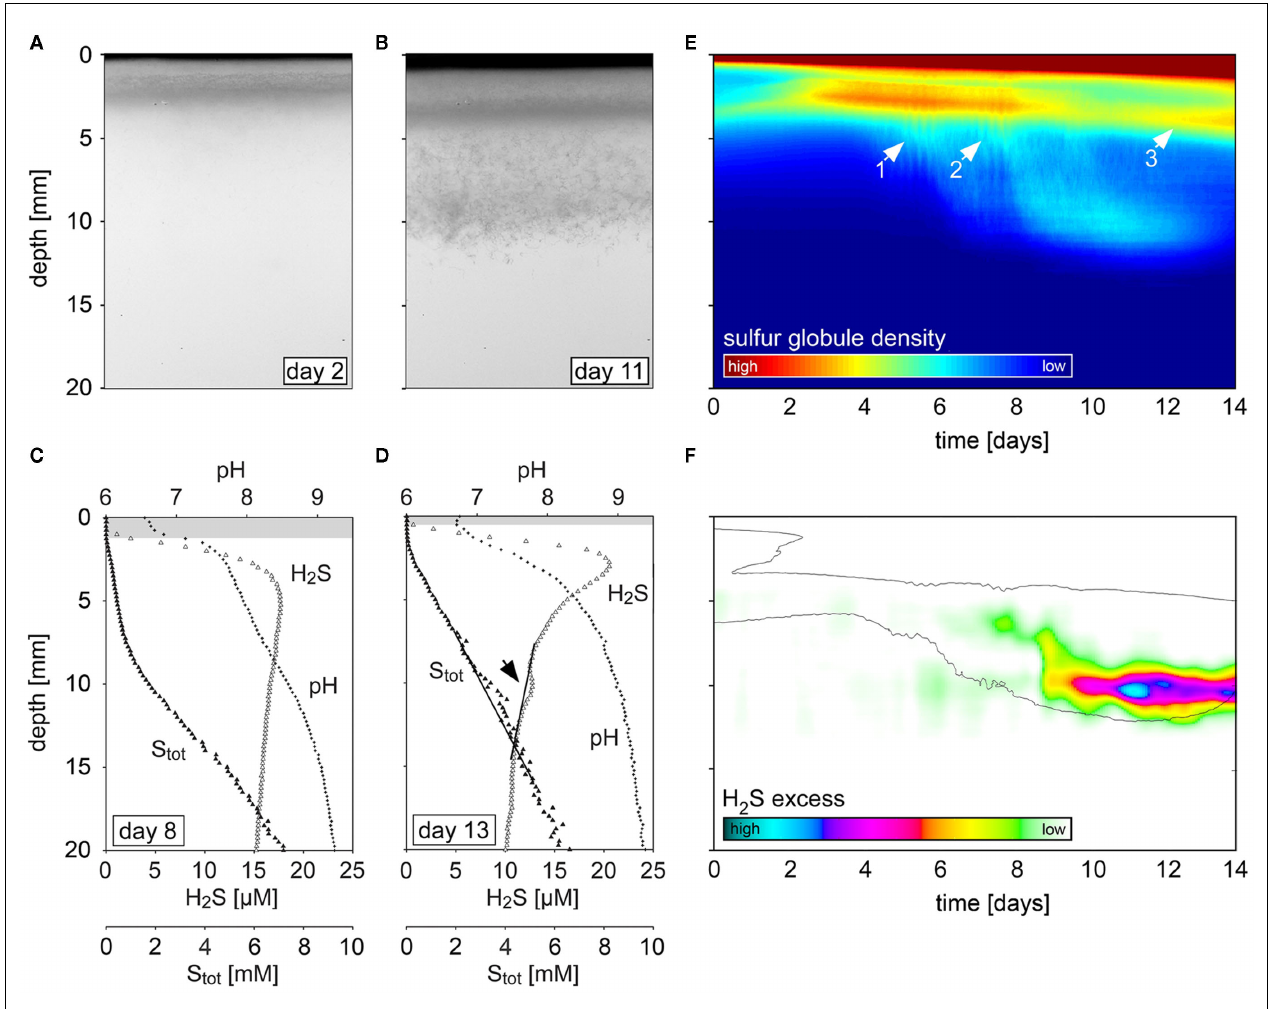
these events varied amongst experimental runs, the general pattern was reproducible. A time-lapse movie of migrating filaments, from which the sulfur-globule density plot was calculated, is provided as a supplementary material (Movie S1 in Supplementary Material). (F) H 2 S excess as a function of time and depth, calculated by subtracting the measured H 2 S profile from the background trend.The trend was derived from the H 2 S concentrations measured above and below the peak [line indicated by arrow in (D) ]. Contour lines of the sulfur-globule density from (E) are overlaid. Data shown in (A,B,E,F) are from the same culture tube, profiles in (C,D) are from a parallel culture